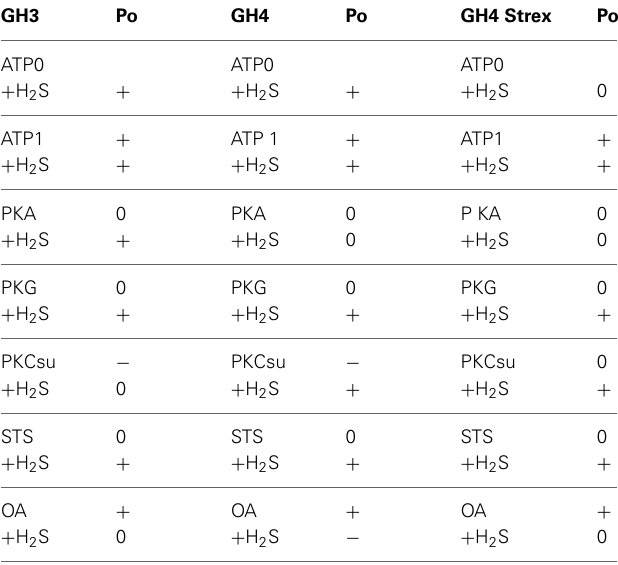
Table 3 | Summary, of open probability (Po) of BK channels in the absence (ATP0, first line) and presence of ATP1 (1mM, all other lines), during application of PKA (protein kinase A), PKG (protein kinase G), PKC (protein kinase C), STS (staurosporine), OA (okadaic acid), and after application of H 2